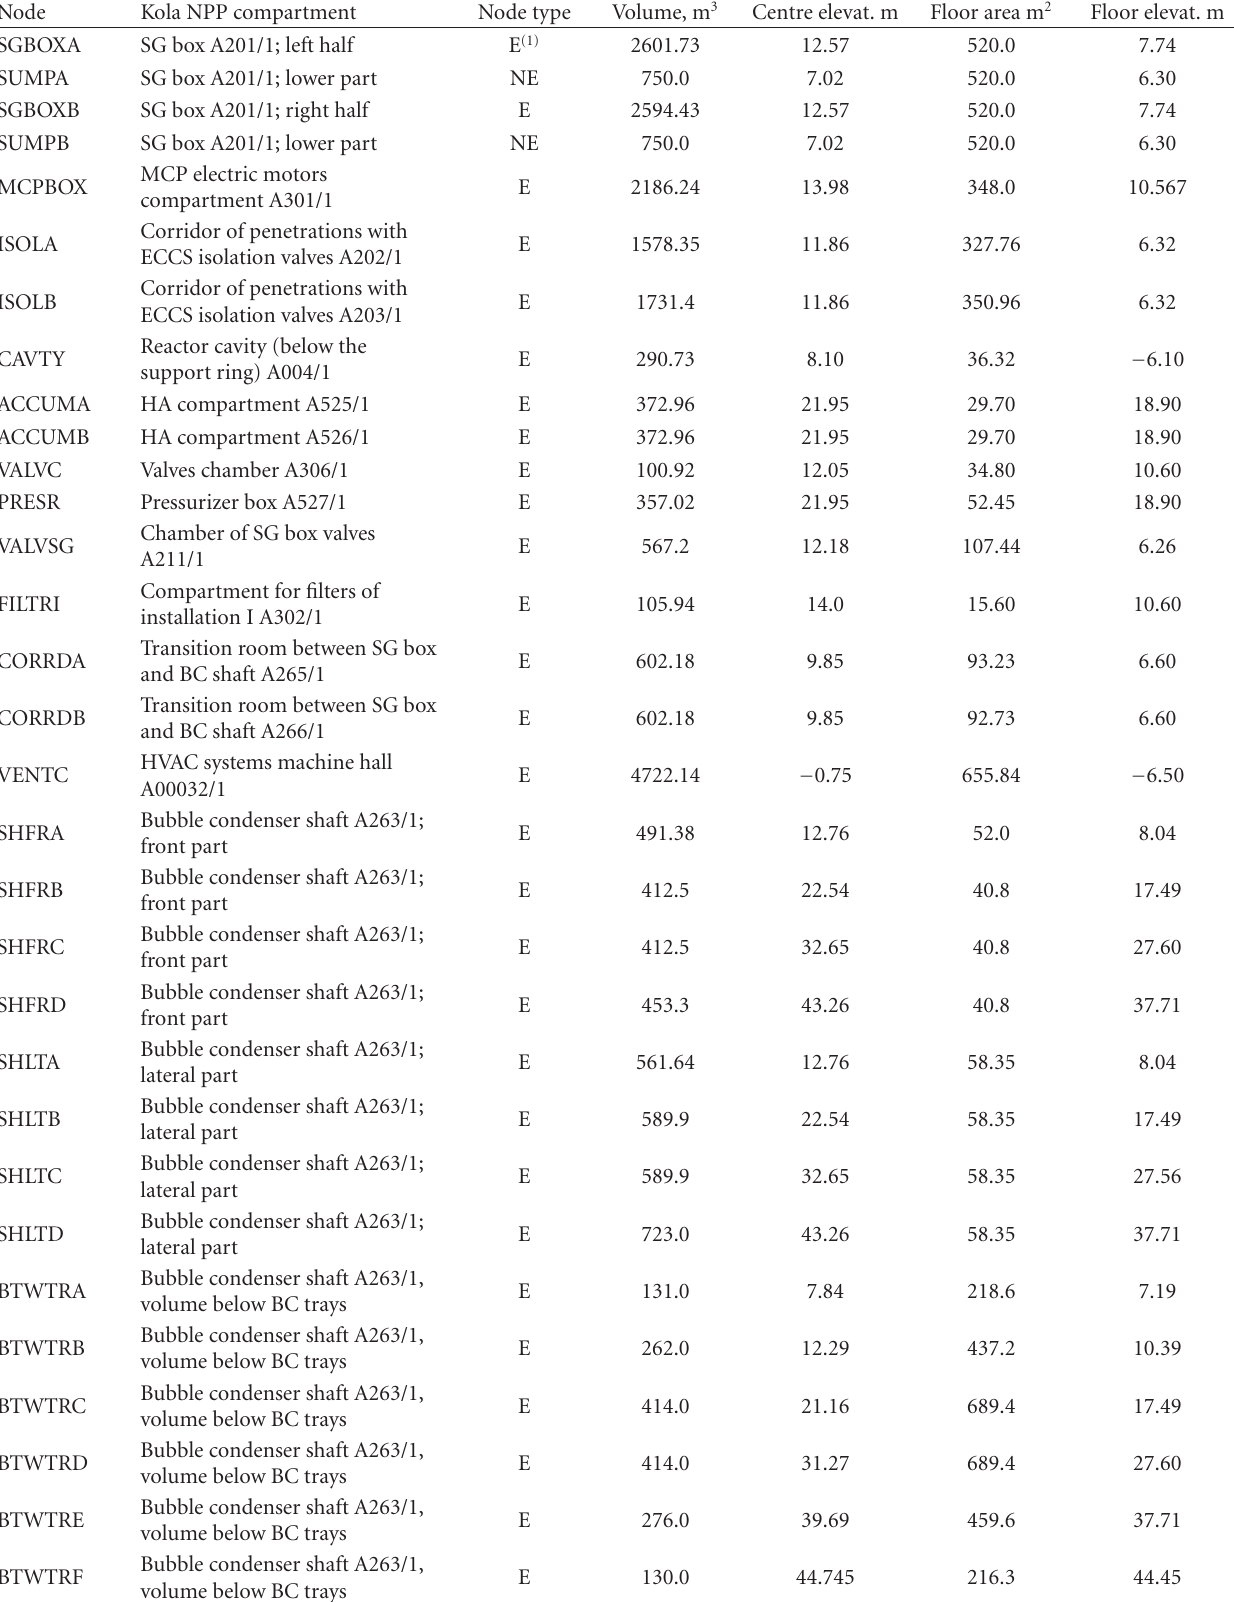
Table 9: List and characteristics of the Kola-3 BCC